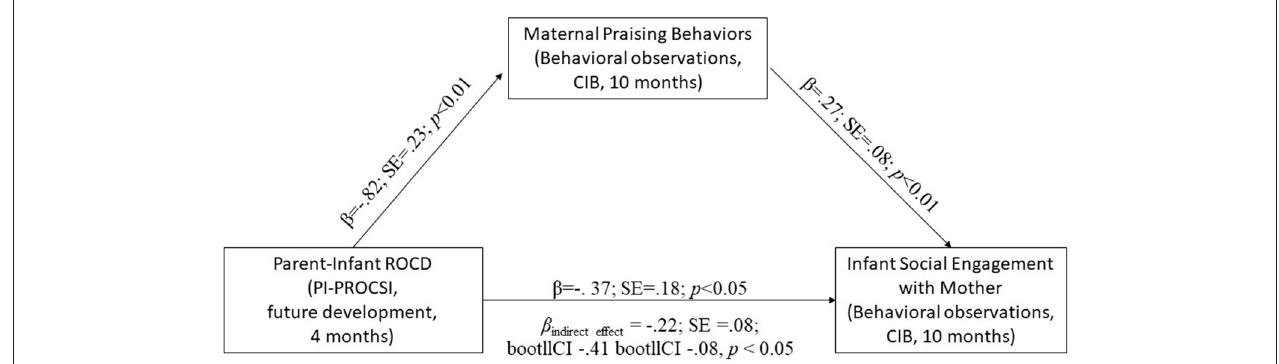
FIGURE 2 | Standardized regression coefficients between PI-PROCSI future development at 4 months and infant social engagement at 10-months mediated by maternal praising at 10-months, controlling for maternal depression and anxiety at 4-months ( N =